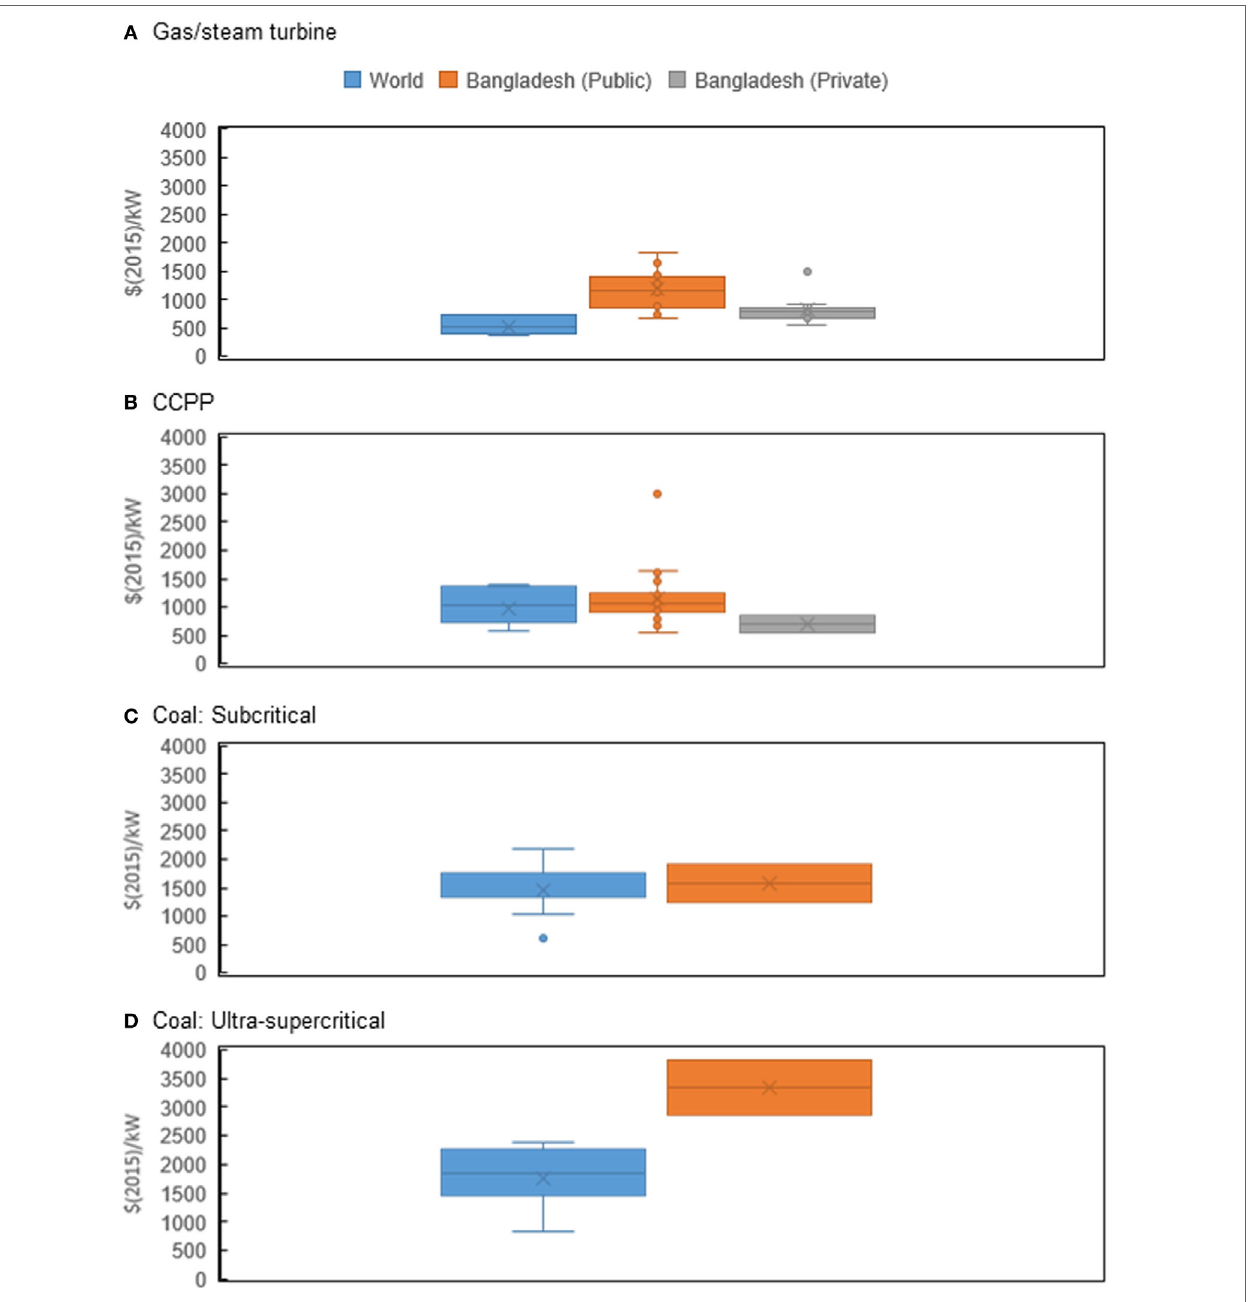
FigUre 3 | Capital cost comparison among fossil fueled power plants from the world with Bangladesh. In the case of gas turbine/steam turbine and combined- cycle power plant (CCPP). Bangladeshi public power plant’s mean capital cost is higher than that of the mean of private and world counterparts. Surprisingly, private power plant’s mean capital cost was lower than the world mean for CCPP. Subcritical coal plant means capital cost is slightly higher than that of global mean. However, ultra-supercritical mean capital cost of Bangladesh would be significantly greater than the world mean. (a) Gas/steam turbine. (B) CCPP. (C) Coal: subcritical. (d) Coal: